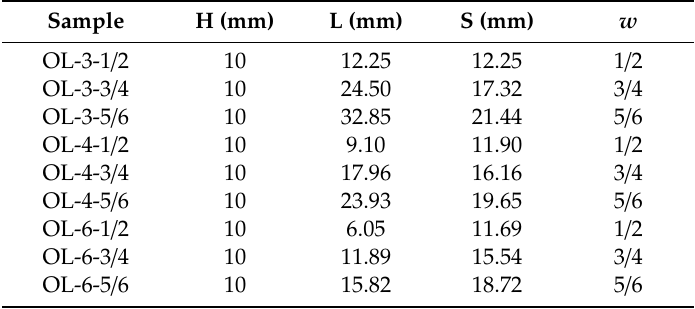
Figure 5. The devised panels of different elements. ( a ) OL-3-1/2; ( b ) OL-3-3/4; ( c ) OL-3-5/6; ( d ) OL-4-1/2; ( e ) OL-4-3/4; ( f ) OL-4-5/6; ( g ) OL-6-1/2; ( h ) OL-6-3/4; ( i ) OL-6-5/6. Table 1. The sizes of the designed orthopyramid-like origami elements.